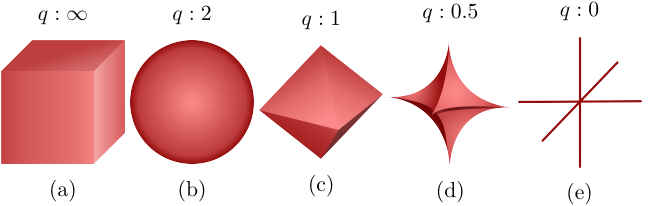
Figure 2. Unit ball representation of ( a ) l ∞ norm ( b ) l 2 norm ( c ) l 1 norm ( d ) l 1 in the three dimensional space R 3